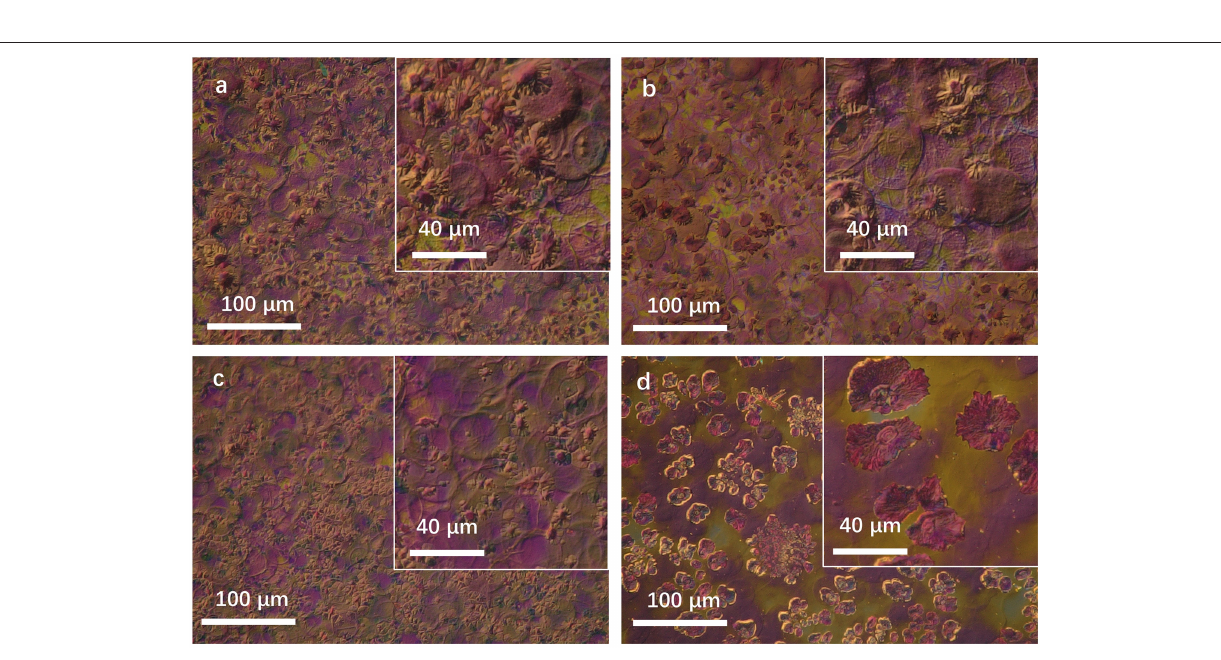
Frontiers in Chemistry |